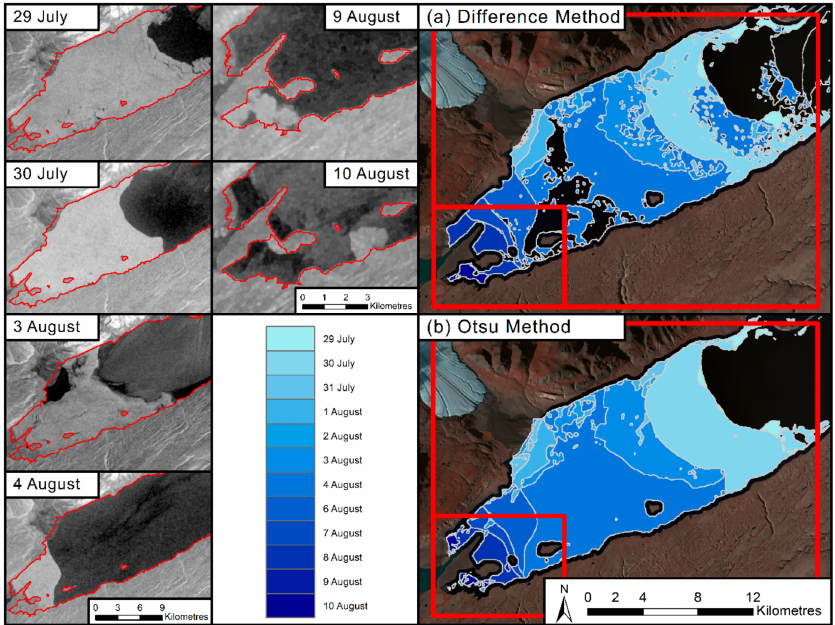
Figure 15. Tracking the progression of ice during the end of break-up in 2018 using the first di ff erence method ( a ) and Otsu method ( b ). Landsat-8 Level-1 image courtesy of the U.S. Geological Survey (Digital Object Identifier (DOI) number: / 10.5066 / F71835S6); this figure also contains Copernicus Sentinel-1 data (2018), processed by